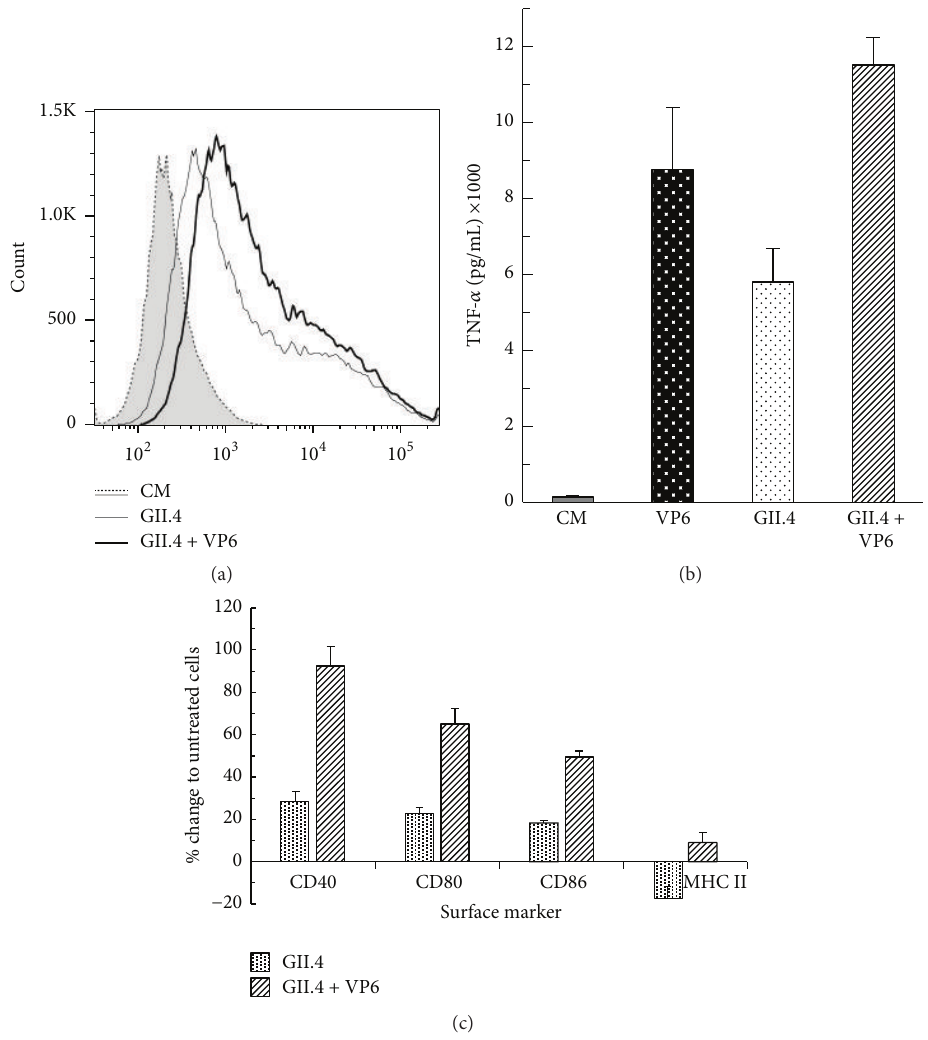
Figure 6: Internalization and activating/maturating effect of NoV GII.4 VLPs alone or combined with RV VP6 nanotubes on RAW 264.7 cells. (a) Flow cytometry analysis of GII.4 VLPs uptake by RAW 264.7 cells after 24 h incubation with 100 𝜇 g/mL of GII.4 VLPs alone or mixed with 100 𝜇 g/mL of VP6 nanotubes. The intracellular staining of untreated cells (CM), GII.4 VLP treated cells, and GII.4 + VP6 treated cells, of a representative experiment of two independent analyses, is shown. (b) The level of TNF- 𝛼 in cell-culture supernatants as measured by ELISA after 24 h incubation with 100 𝜇 g/mL of GII.4 VLPs alone, 100 𝜇 g/mL VP6 alone, or GII.4 VLPs mixed with 100 𝜇 g/mL of VP6 nanotubes. Shown are the mean values and standard deviations of two independent analyses. (c) The expression of cell surface markers measured by flow cytometry after 24 h stimulation. The results represent % increase or decrease of the MFI of each marker on the cells incubated with GII.4 VLPs alone or with combined GII.4 VLPs and VP6 nanotubes compared to baseline level of untreated cells. The mean values with standard deviations of two independent analyses are